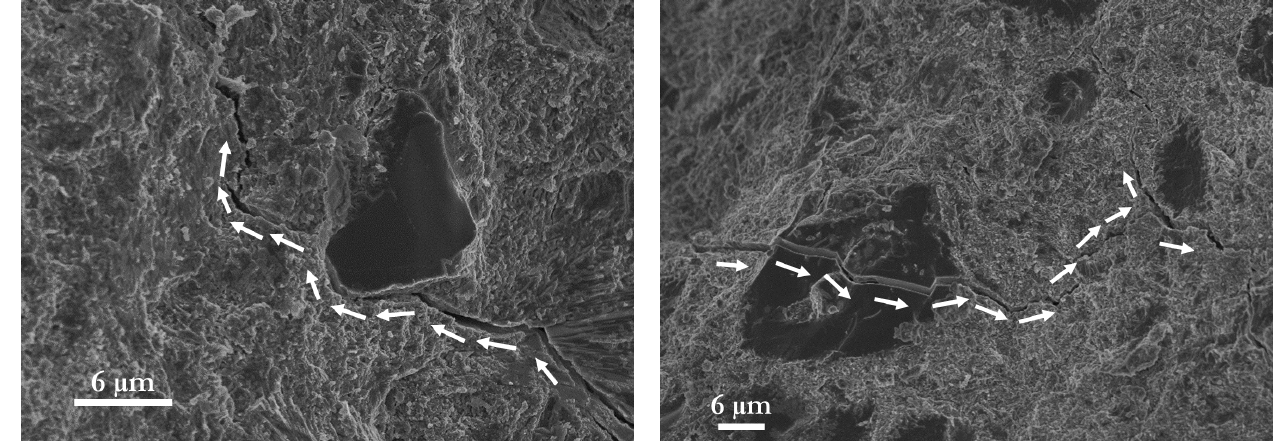
Figure 10: Crack contouring around a pyrolyzed coconut shells particles inclusion.